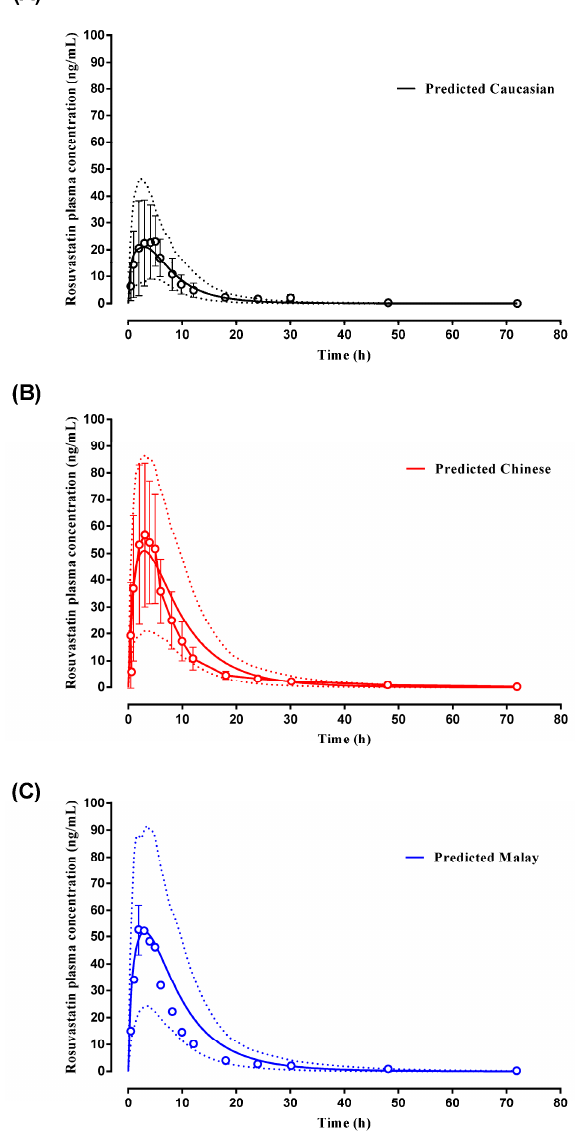
Figure 9. Simulated plasma concentration–time profile of rosuvastatin in ( A ) Caucasian, ( B ) Chinese and ( C ) Malay subjects. A single 40 mg oral dose was administered to adult population groups ( n = 36 for each population group, matching the reported study recruitment for each population group) using the Simcyp Heathy Volunteer (Caucasian), Simcyp Healthy Chinese (Chinese) and custom Malay population groups. Solid lines represent mean predictions with dotted lines representing the 5th and 95th percentile ranges. Open circles represent mean data for the observed study with error bars indicating standard deviation where reported by Lee et al. [48] (and largely missing in results presented by Lee et al. for Malay subjects).